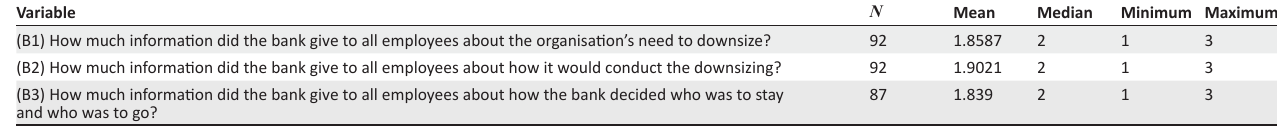
TABLE 2: Descriptive statistics for survivors’ perception of the amount of downsizing information (section B).